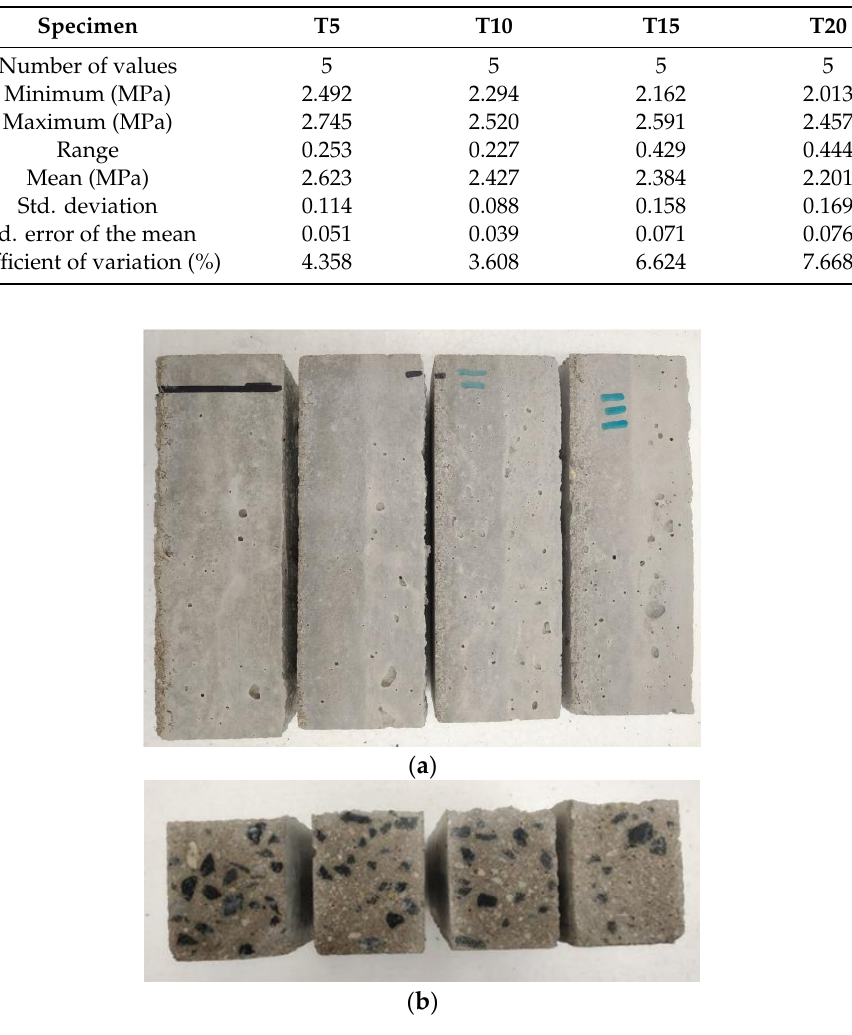
Figure 9. Section view of specimens and details of the layer boundaries (5, 10, 15, and 20 min from left to right). ( a ) side view—visible boundaries; ( b ) section view.